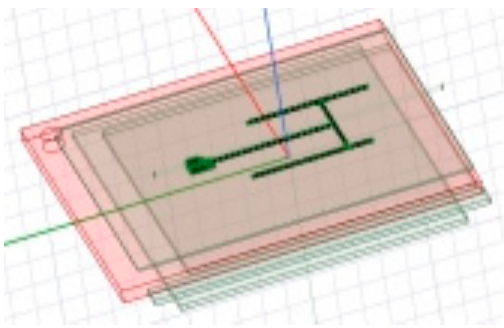
Figure 6. Schematic diagram of grid node setting .